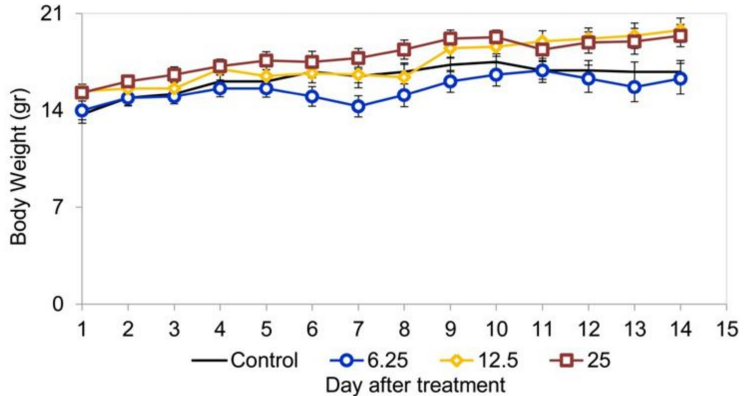
Figure 4. Graph of mice body weights after administration of transgenic sugarcane juice for toxicity assessment. The BALB/c mice ( n = 10/group) were administered transgenic sugarcane juice in a dosage-dependent manner (0; 6.25; 12.5; 25 gr/kg of body weight), and the body weight of the mice were measured daily for 14 days. The body weight values are presented as the mean ± SEM and showed no significant difference ( p > 0.05) between